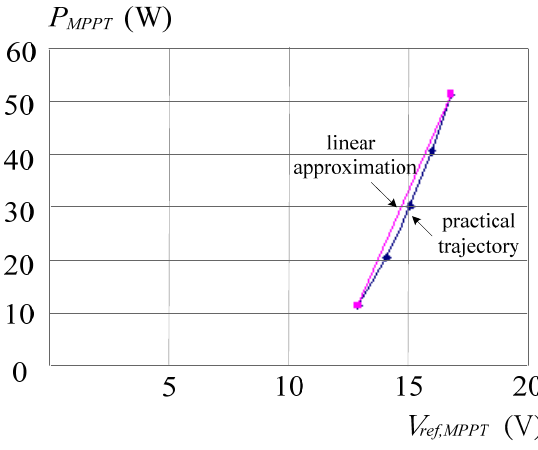
Figure 4. The relationship between P 200 to 1000 W/m 2 .